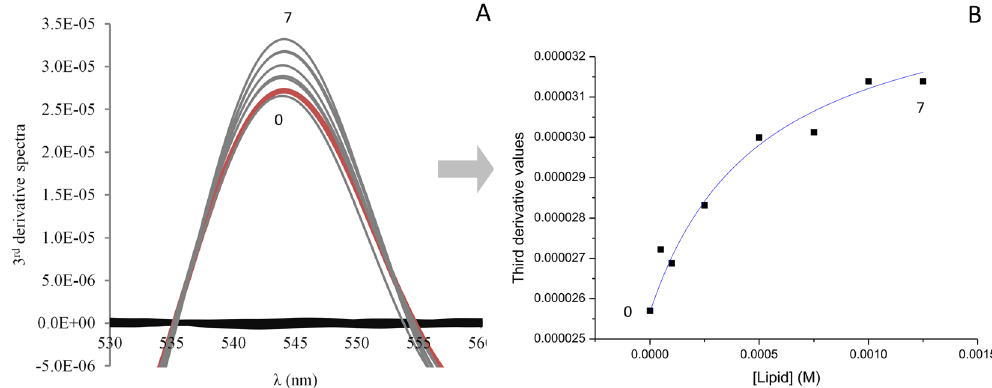
Figure 2. Third-derivative absorption spectra ( A ) of doxorubicin (40 μ M) (red line, 0) alone, incubated in DMPC:SM model membrane at 37 °C with increasing lipid concentration (7 represents the maximum lipid concentration) and the model membrane without drug (black lines). ( B ) represents the best fitting curve to